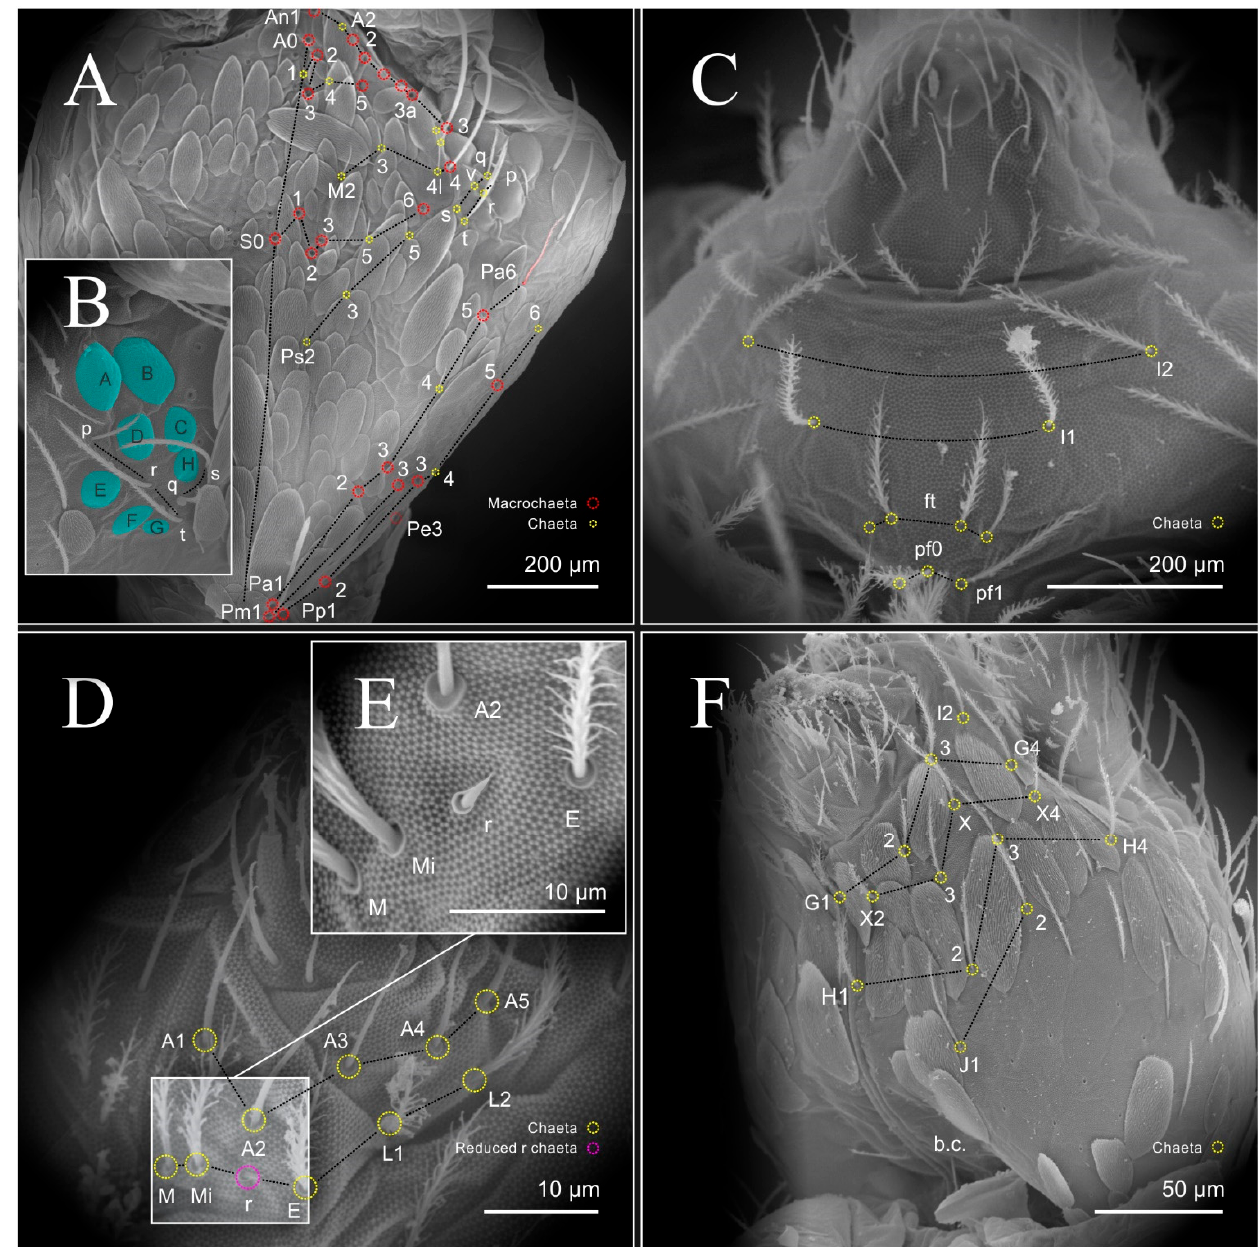
Figure 9. Seira musarum SEM: head chaetotaxy: ( A ), dorsal head; ( B ), eyes; ( C ), clypeus; ( D ), ventral head basomedial and basolateral labial fields; ( E ), r-chaeta position details; ( F ), postlabial. Thorax chaetotaxy (Figure 10). Th II (Figure 10A): a, m and p series with two mic (a2p and a5ip), four mac (a5–i2 and a5p), four mic (m1i2, m4ip, m5 and m5p), seven mac (m1i, m2i, m4i, m1, m2, m4 and m4p), three mic (Pma 1i2p, p4 and p6) and fourteen mac (PmA p1, 1p, 1i, 1ip and 1i2; PmB 2a, p2 and 2p; PmC p3, 3p, 2ea, p2e and 2ep; p5), respectively; apex distal with numerous mac, meso and scales interspersed. Th III (Figure 10A): a, m and p series with three mic (a1a, a3 and a7), five mac (a1, a2, a4, a5 and a6), five mic (m1, m4, m5, m7, m6p), one mac (m6), three mic (p4—6) and four mac (p1, p2, p2a and p3),